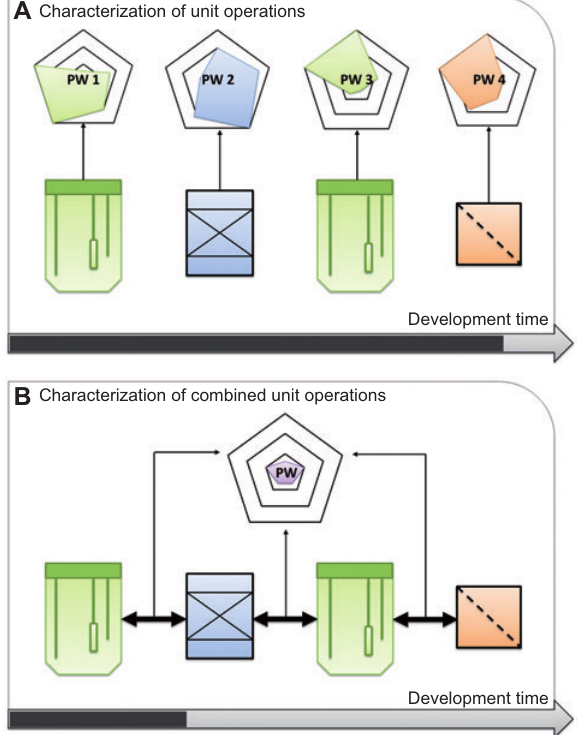
Figure 1 Illustration of a possible sequence of unit operations within a bioprocess comparing the development time to character- ize all unit operations within their specific process windows (PWs) with the development time when characterizing the combined unit operations in a common smaller process